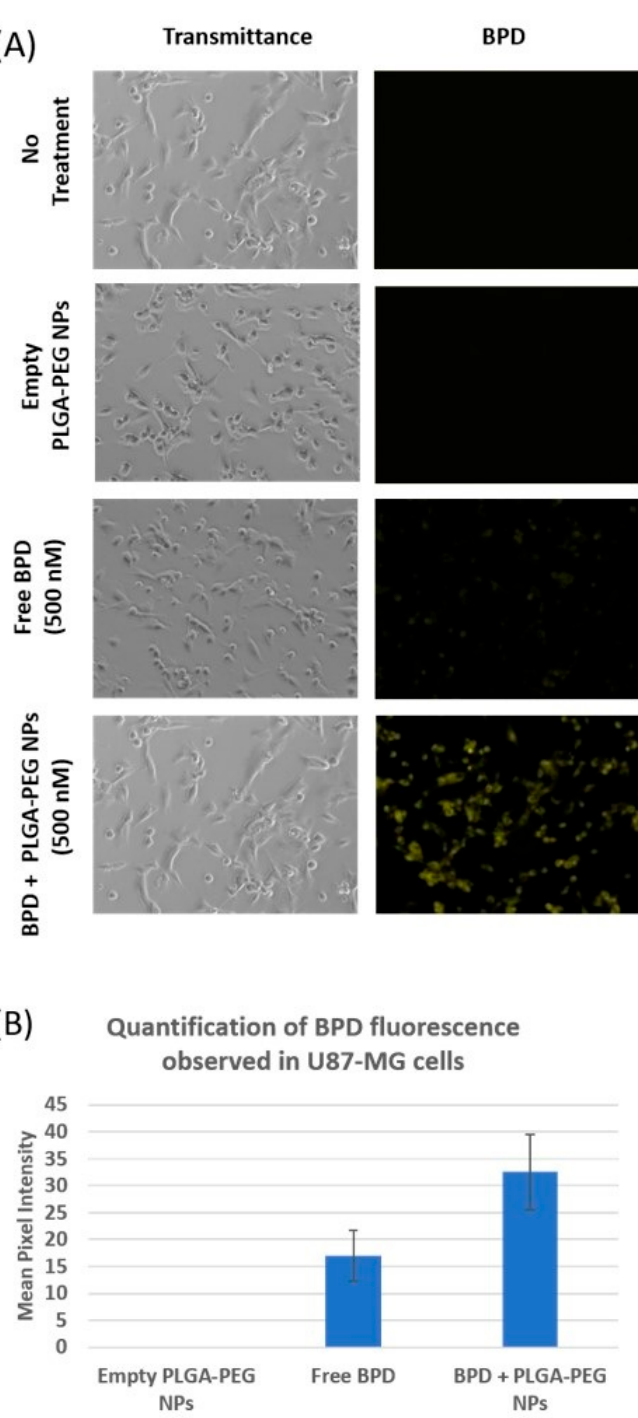
Figure 5. ( A ) Cellular uptake of 500 nM BPD encapsulated NPs captured under brightfield and Cy5 filters. Cells incubated with free BPD (500 nM) with two controls are also represented in this image: Empty PLGA-PEG NPs and cells with no treatment. ( B ) Mean pixel intensity of the fluorescence emitted by BPD in U87-MG is indicated comparing the empty PLGA-PEG NPs, free and nano BPD.